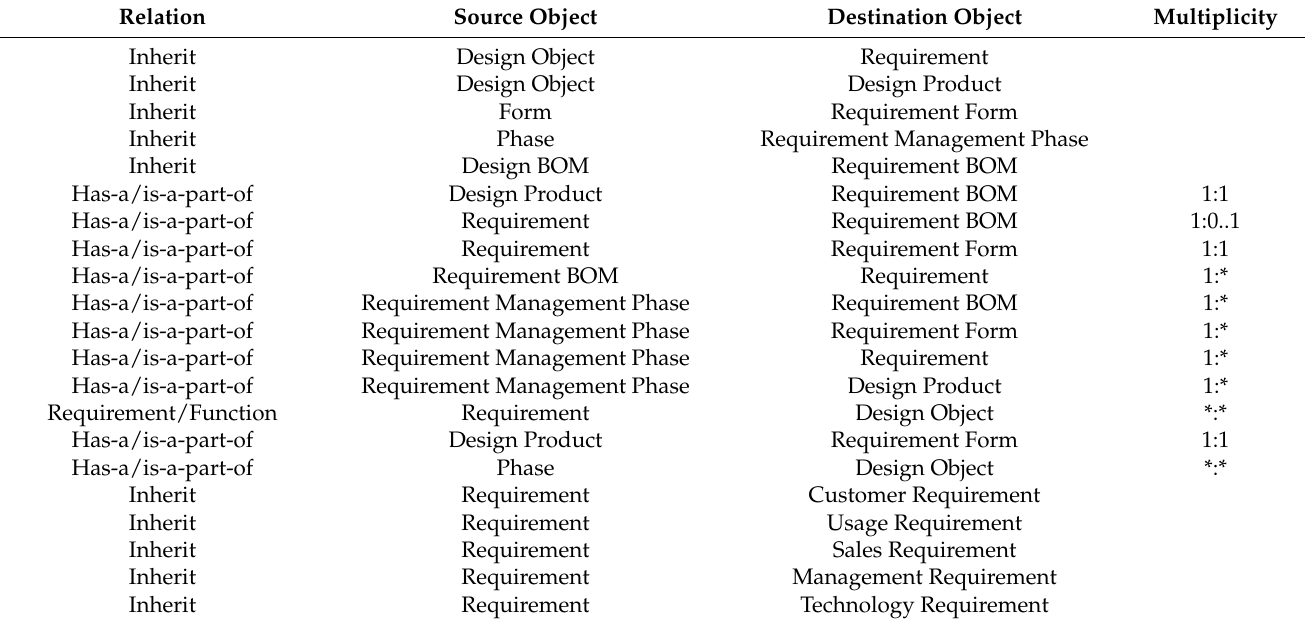
Table 5. Set of rules in the requirements management phase (1, * represent the one and multi-object).